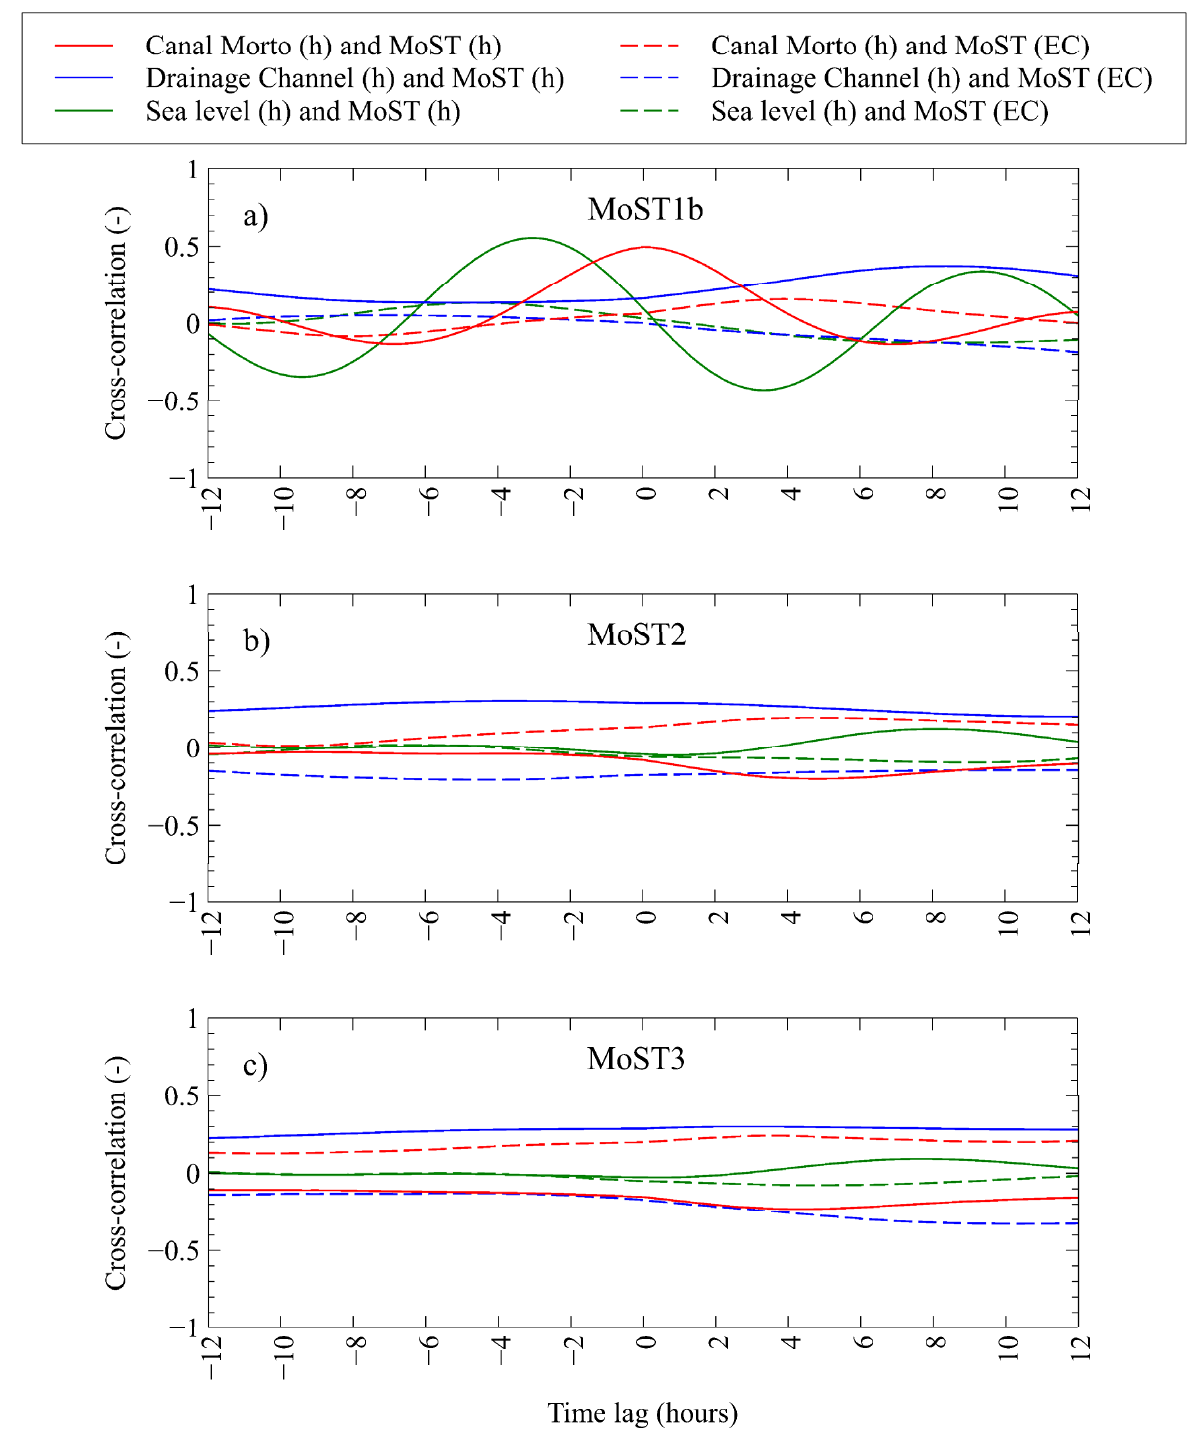
Figure 10. Cross-correlation functions determined for the period 2–19 September 2020: ( a ) piezometer MoST1b; ( b ) piezometer MoST2; and ( c ) piezometer